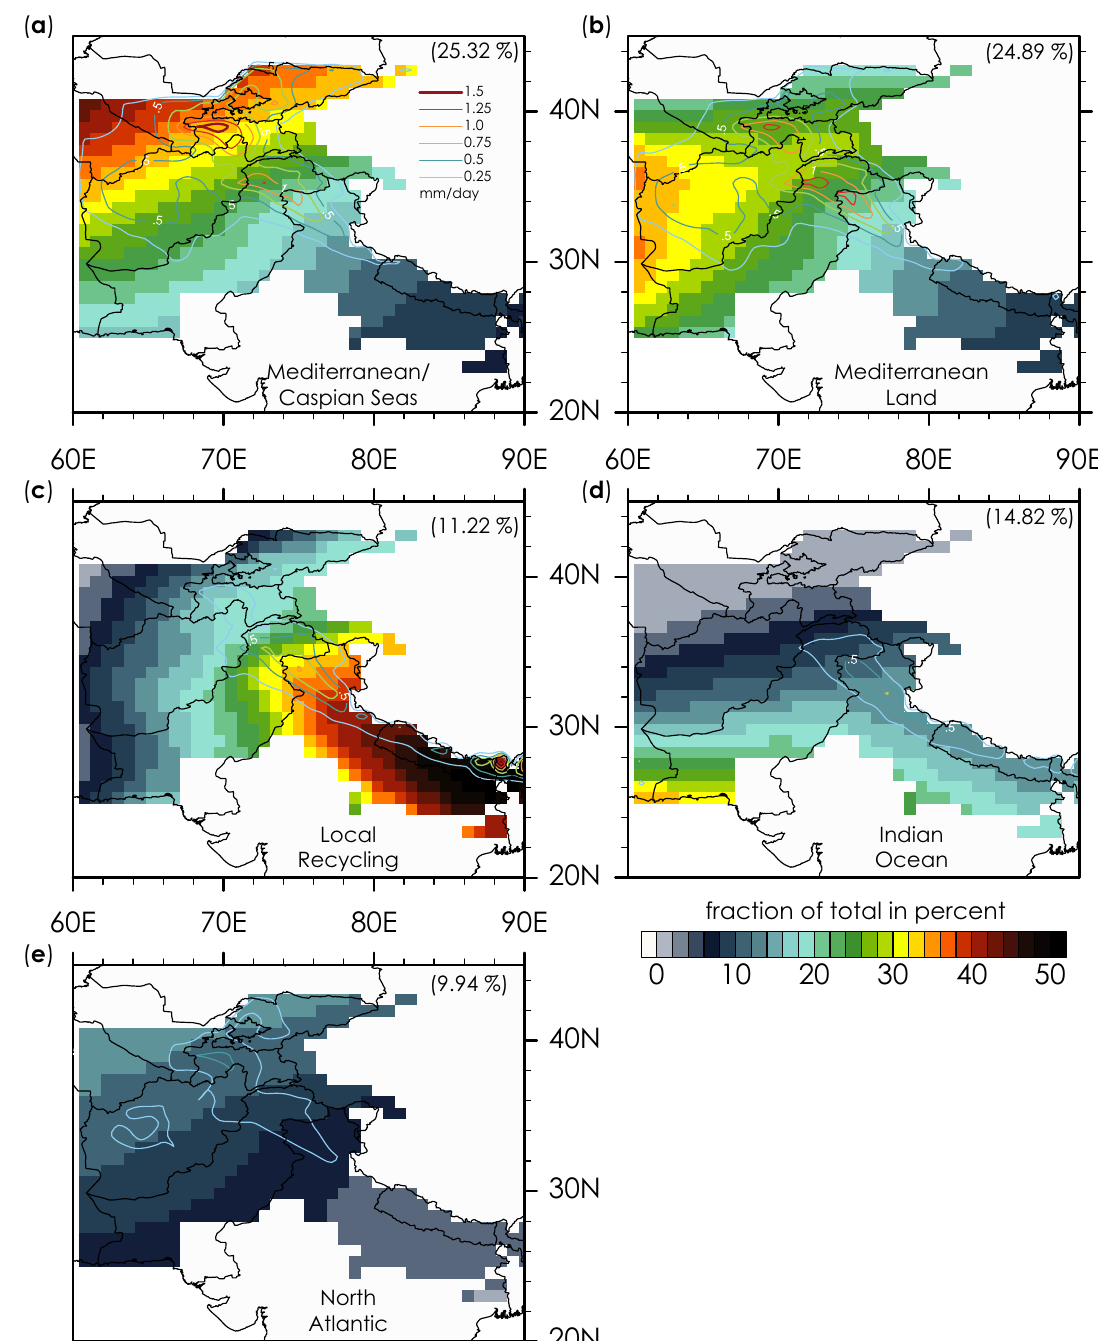
Fig. 2 Seasonal (November – March) recycling ratio and recycled precipitation from individual source regions. Seasonal fraction (expressed in %) of moisture falling as precipitation at each grid cell that originated as evapotranspiration ( fi lled contours) over the individual evaporative source subregions and corresponding recycled seasonal precipitation (mm/day; line contours). a Mediterranean/Caspian Seas, b Mediterranean land, c local recycling, d Indian Ocean, and e North Atlantic. The numbers within parenthesis in each panel represent area-averaged seasonal percent contribution to the total recycled precipitation. This analysis shows an average of ERA5, MERR2, and ERAI from 1981 to Mediterranean/Caspian Seas and Mediterranean land throughout Moisture contributions from individual sources exhibit sub- the cold season. The moisture from the Mediterranean/Caspian seasonal variations, while their total contribution remains stable Seas reduces to almost half (~20%) of their contribution to the throughout the season, represented as the recycling ratio early season (~35%). In contrast, an increase of 15 – 20% is seen (0.89 – 0.96) (Fig. 3). Some disagreements in the sub-seasonal from the Mediterranean land by the end of the season. Up to a magnitudes of regional contributions also exist across the 50% decline in contribution from the Indian Ocean is also reanalysis datasets. Over half of moisture comes from the